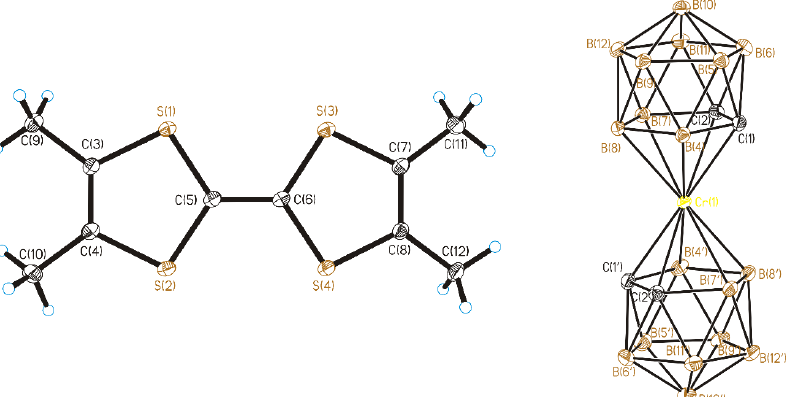
Figure 1. TMTTF radical-cation and anion in ( 1 ). Thermal ellipsoids are given at 30% probability level. Cage H atoms omitted for clarity.